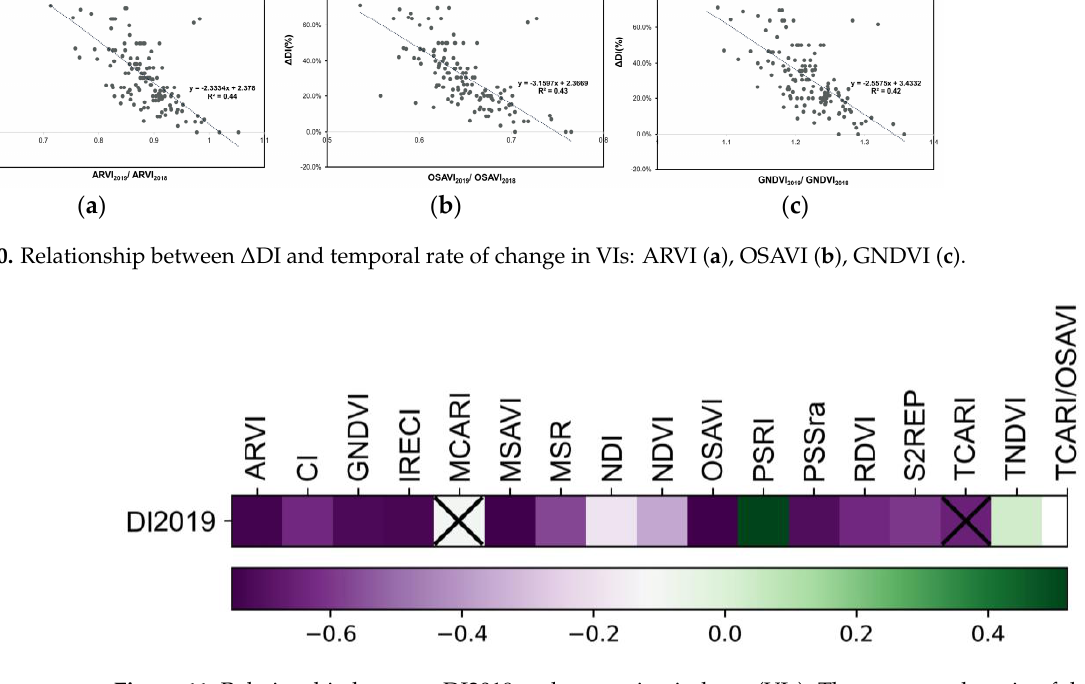
Figure 11. Relationship between DI2019 and vegetation indexes (VIs). The range co-domain of the correlation coefficients is shown in the color bar. (X) symbols represent non-significant relationships ( p ≥ 0.001).